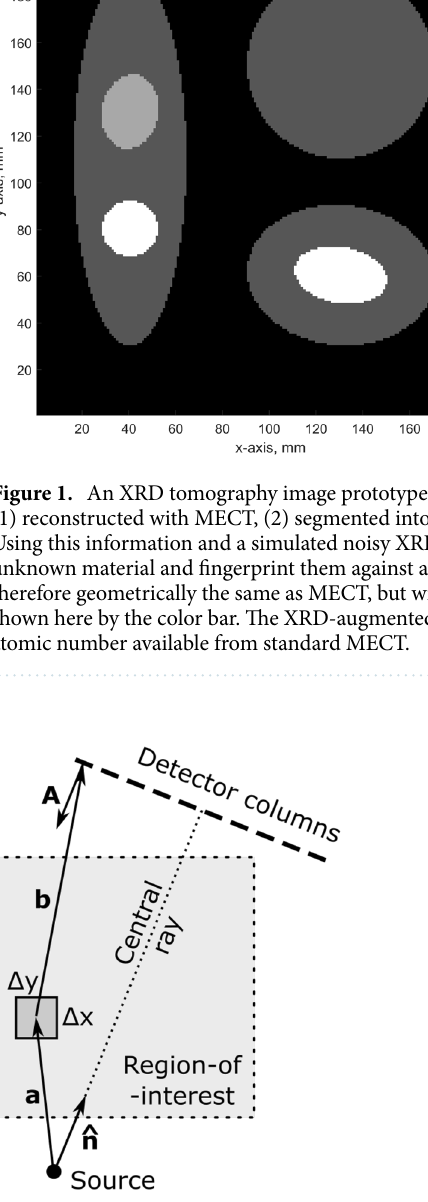
source-to-voxel vector , = n , whereas the detector pixel surface is given by ˆ 32 discrete =